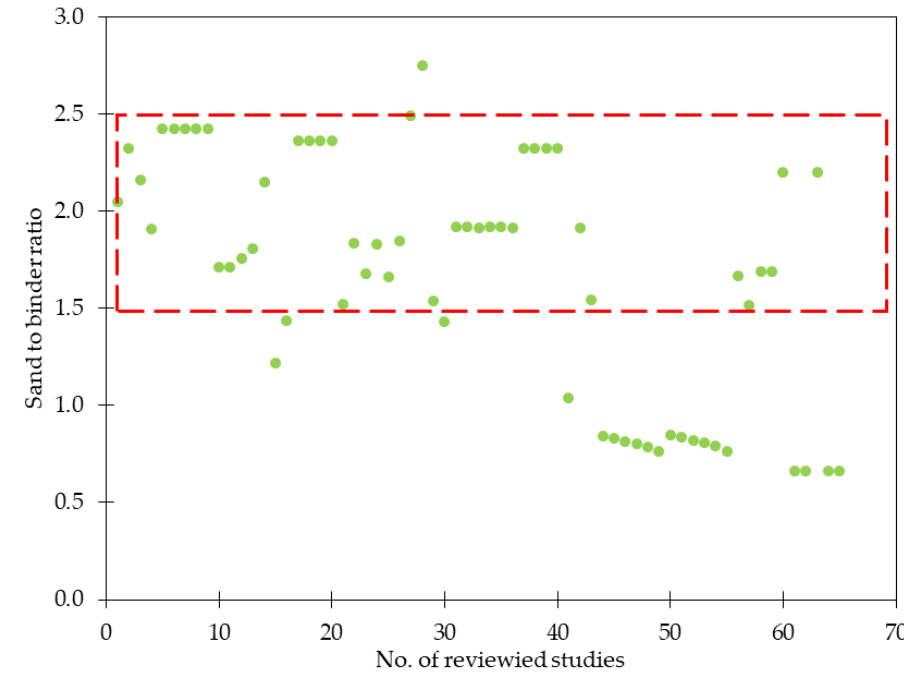
Figure 3. Sand to binder ratio in studies presented in Table 3.